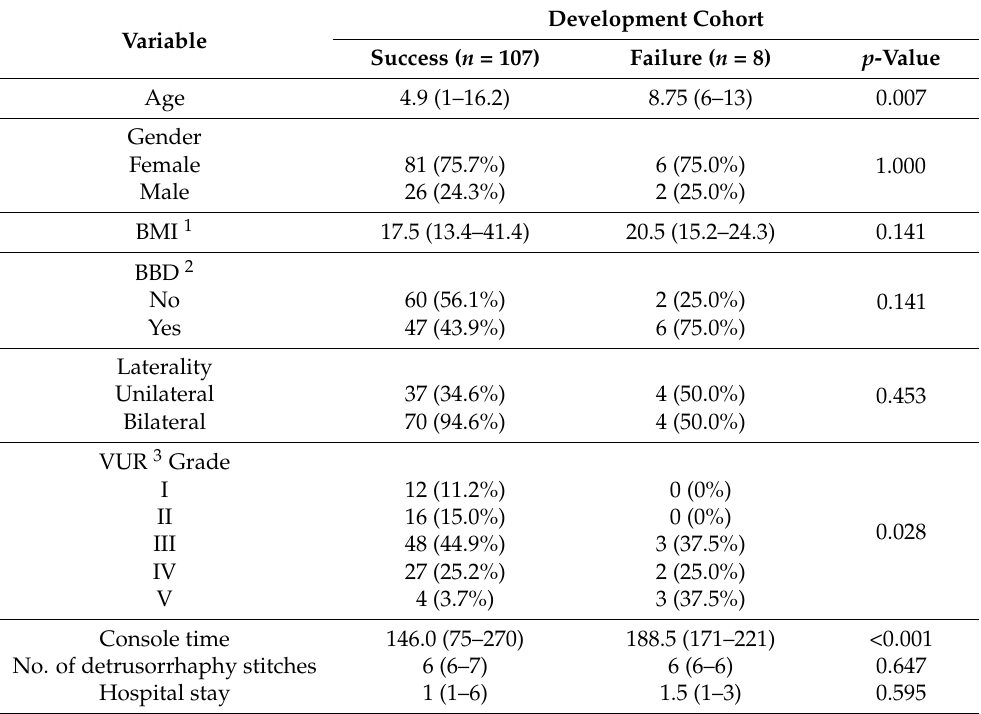
Table 2. Univariate analysis according to clinical success or failure of renal units in the develop- ment